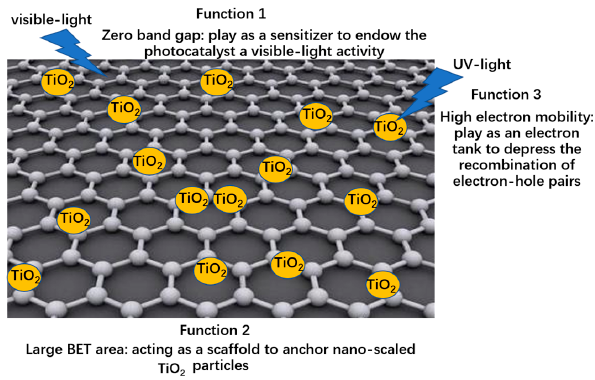
Figure 1. Three major functions of graphene in the resulting composite photocatalysts.